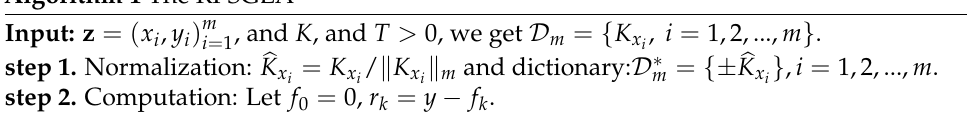
Algorithm 1 The